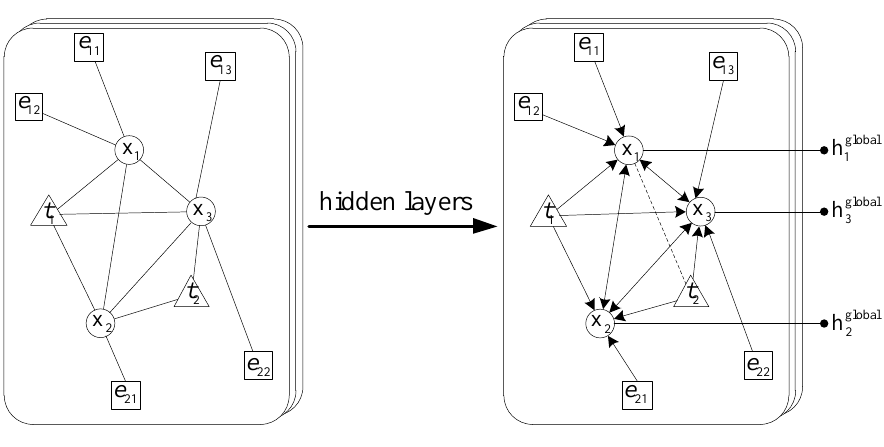
Figure 4. Schematic of our GCN